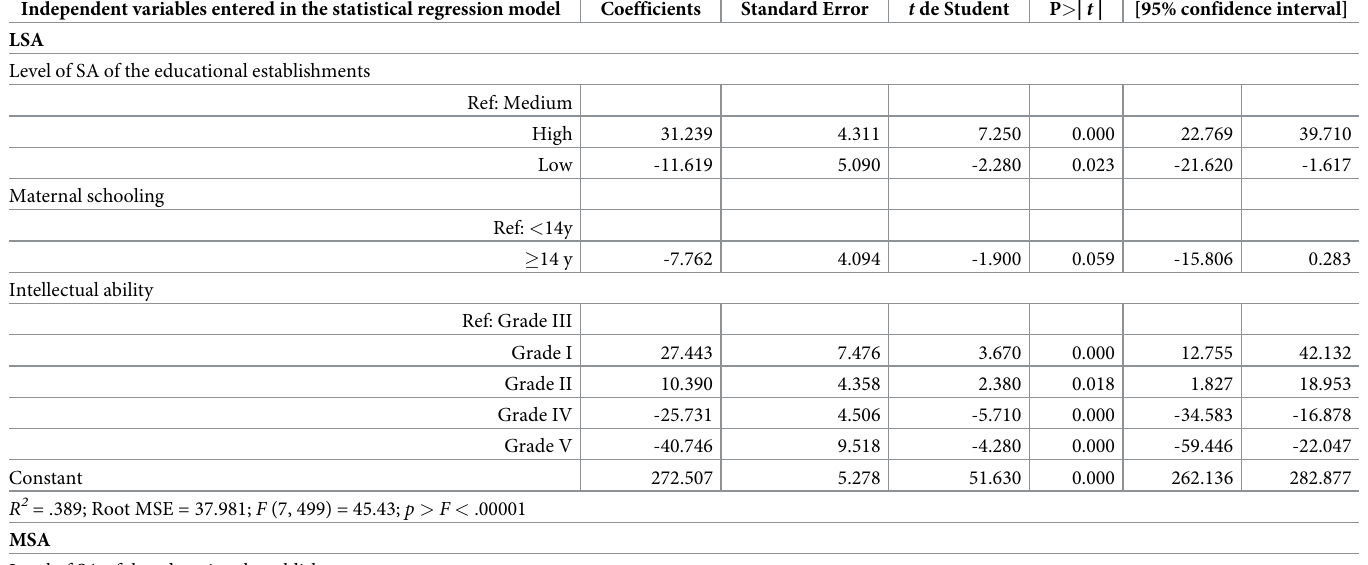
Table 3. Multiple regression models between language (LSA) and mathematics (MSA) scholastic achievement (SA) in the Education Quality Measurement System (2009 SIMCE) tests (dependent variables) and most relevant independent variables in school-age children of the 2010 1HSG. Independent variables entered in the statistical regression